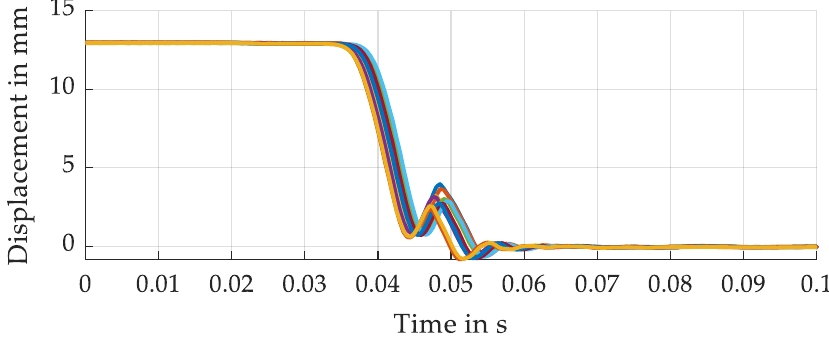
Figure 12. Measured displacement signals for all measurements.